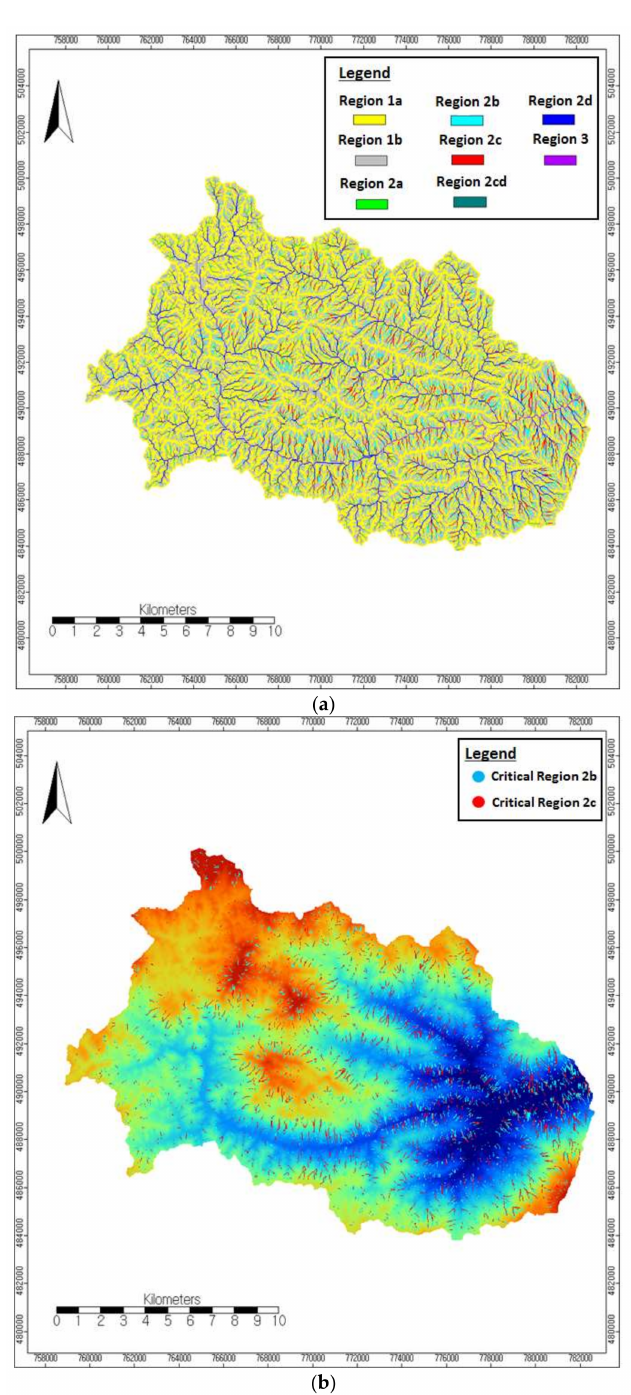
Figure 8. Distribution of stability domains for the Susu River Basin, categorized by stream power: ( a ) characteristic regimes; ( b ) critical regimes: Region 2b and Region